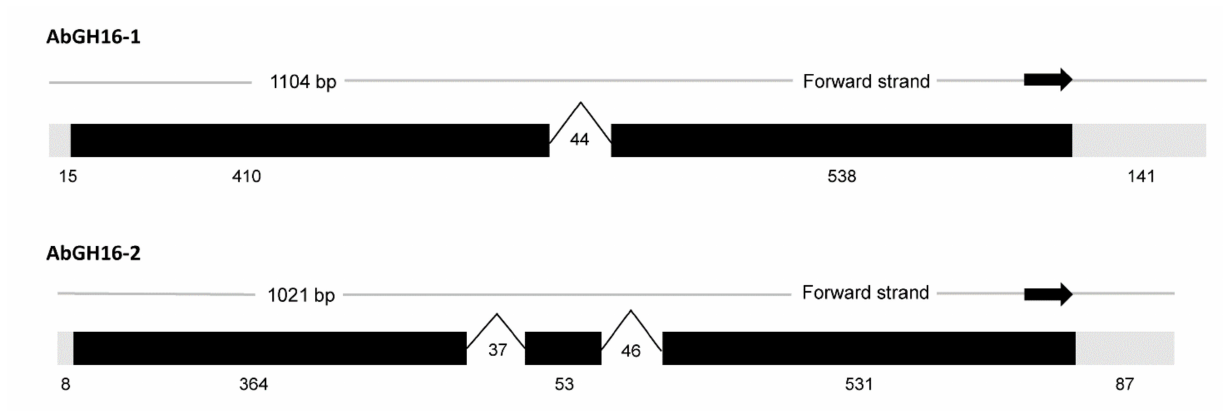
Figure 1. The gene structures of two GH16 genes in A. besseyi. One 44 bp-sized intron was found in AbGH16-1, while two introns with 37 bp and 46 bp separately, were present in the